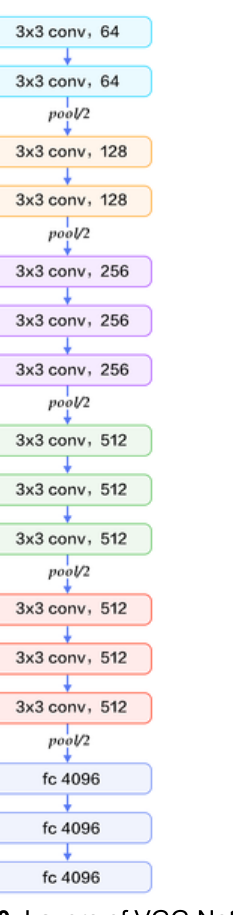
Figure 10. Layers of VGG